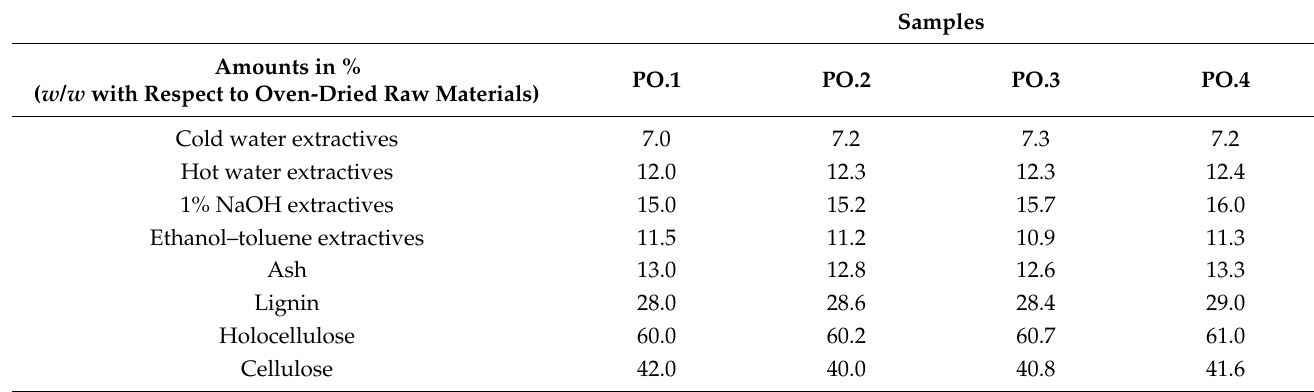
Table 1. Chemical composition of Posidonia oceanica